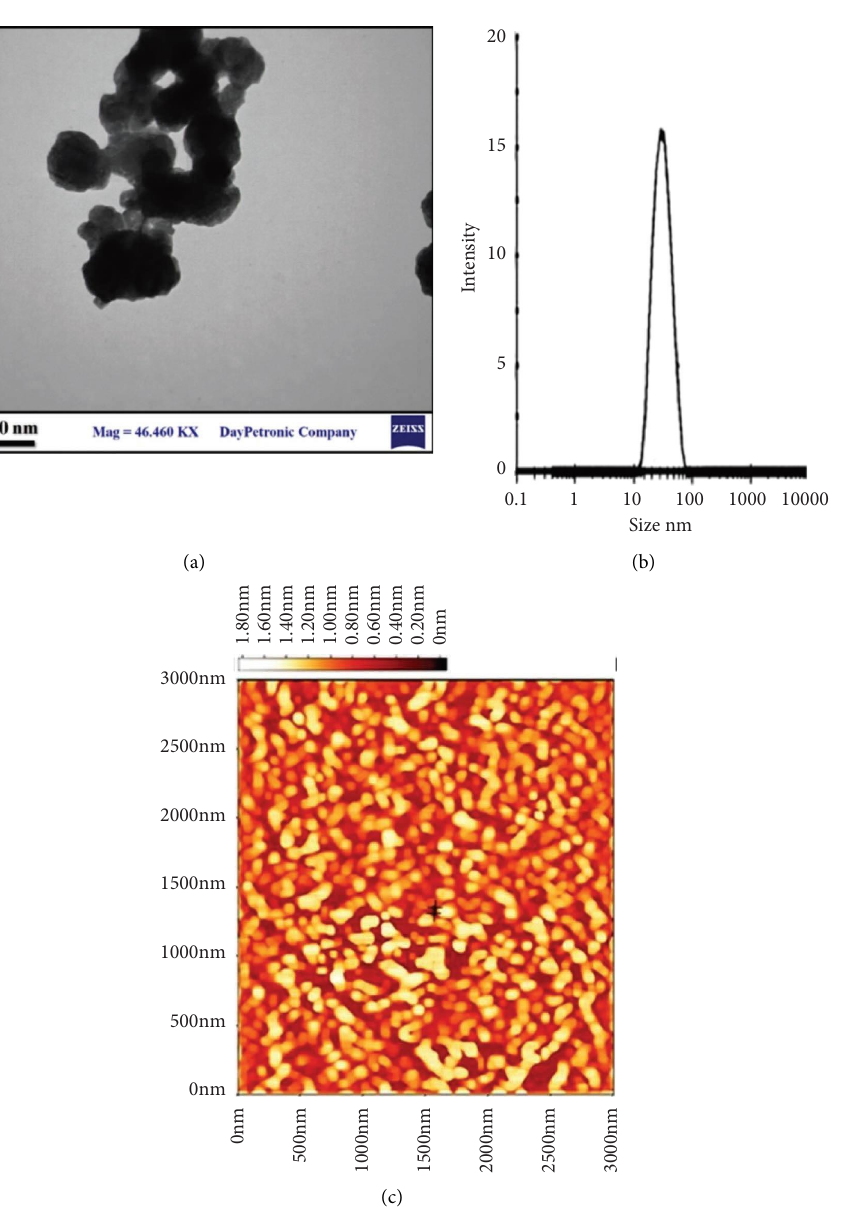
Figure 1: Characterization of ZnO NPs. (a) TEM. (b) DLS. (c) AFM histogram image showing uniformly distributed nanoparticles with spherical